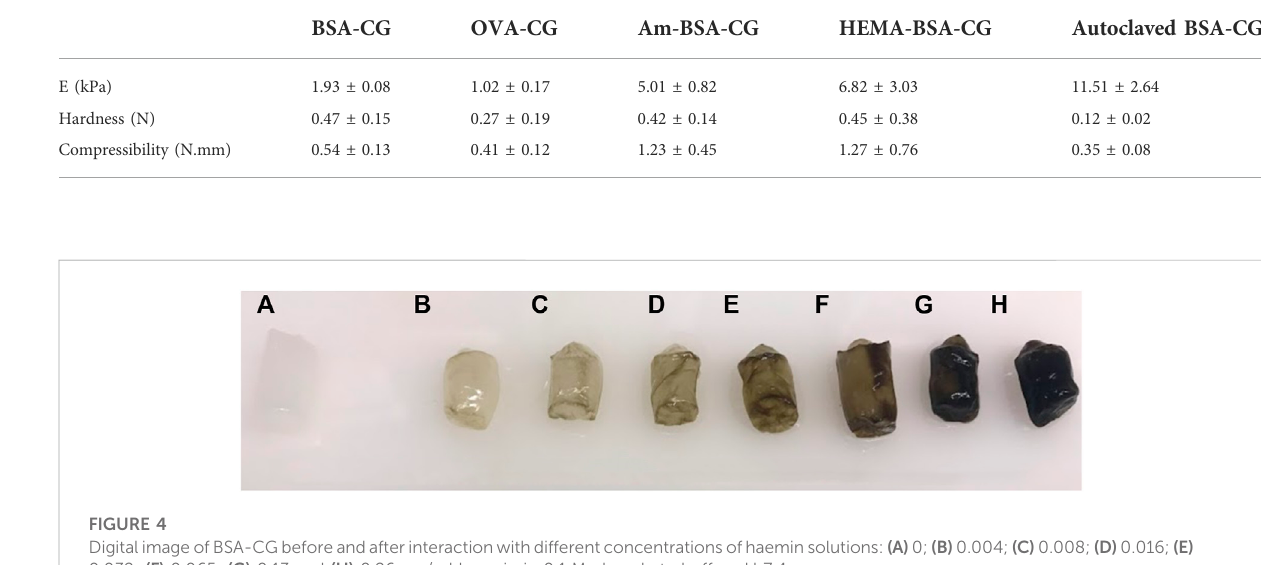
TABLE 2 The mechanical properties of the cryogels.